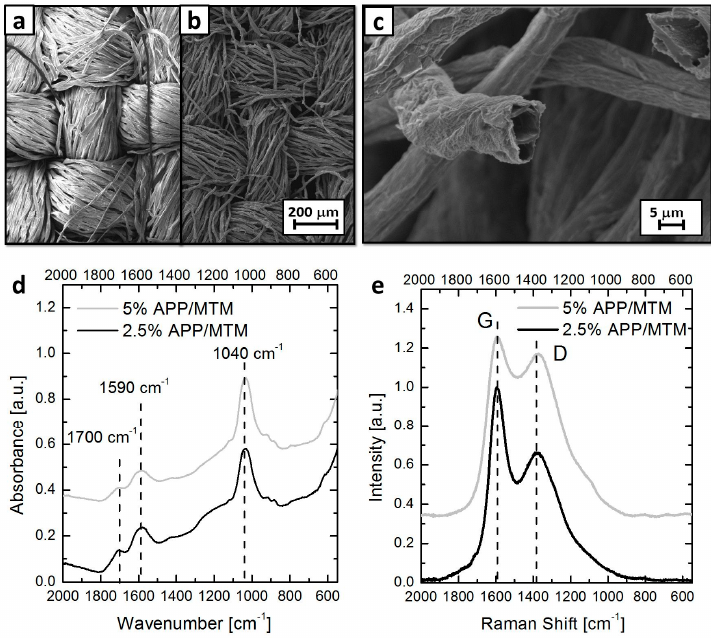
Figure 6. Analyses on residues after cone calorimetry: low magnification SEM (Scanning Electron Microscopy) micrograph performed on unburned ( a ) and burned ( b ) areas of 5% APP/MTM; detail of 5% APP/MTM fibers after combustion ( c ); and FT-IR/ATR and Raman spectra ( d , e ). As observable